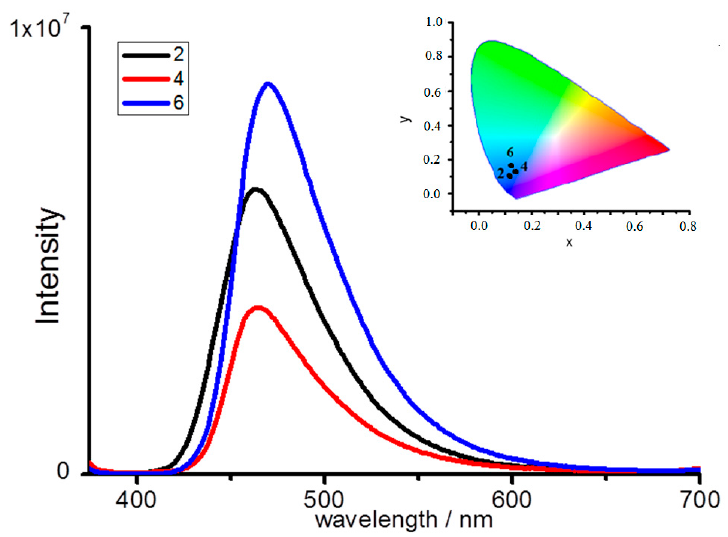
Figure 4. Emission spectra of magnesium complexes in solid state and the corresponding color coordinate diagram of emission.